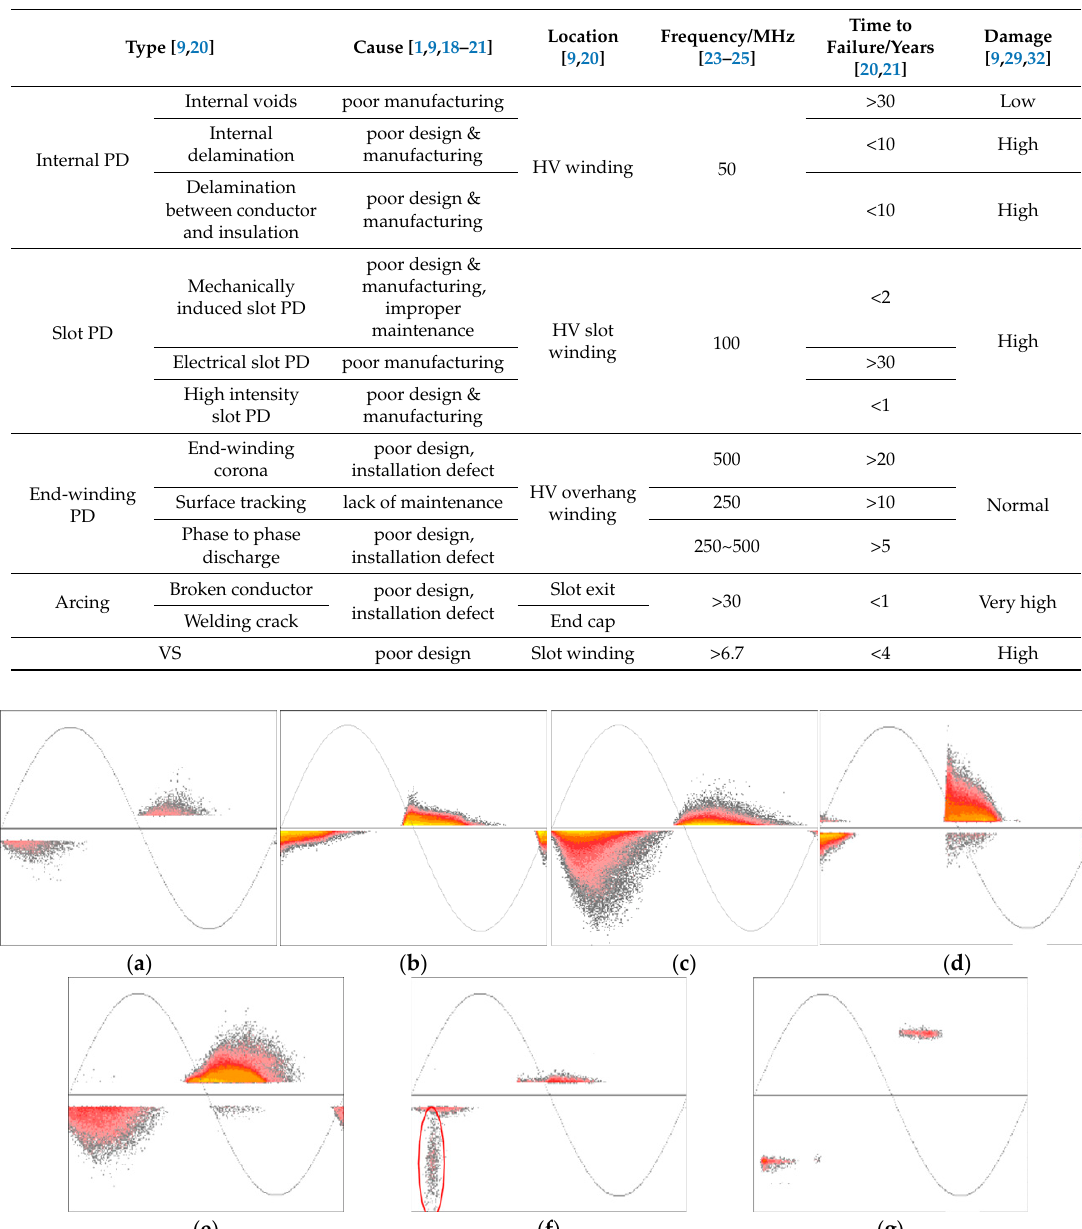
Table 1. Characteristics of PDs in generators.